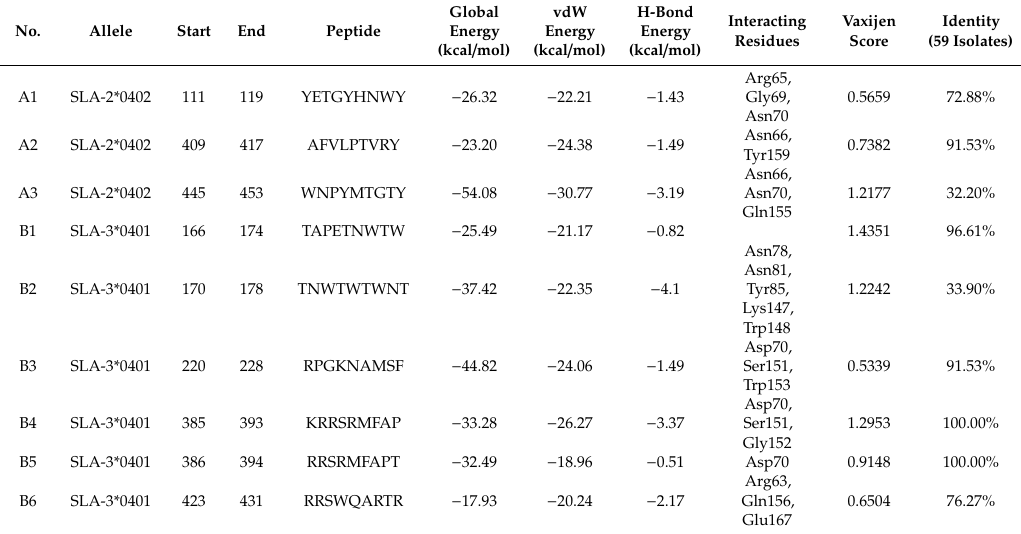
Table 4. Molecular docking results of SLA-2*0402 and SLA-3*0401 with MHC I